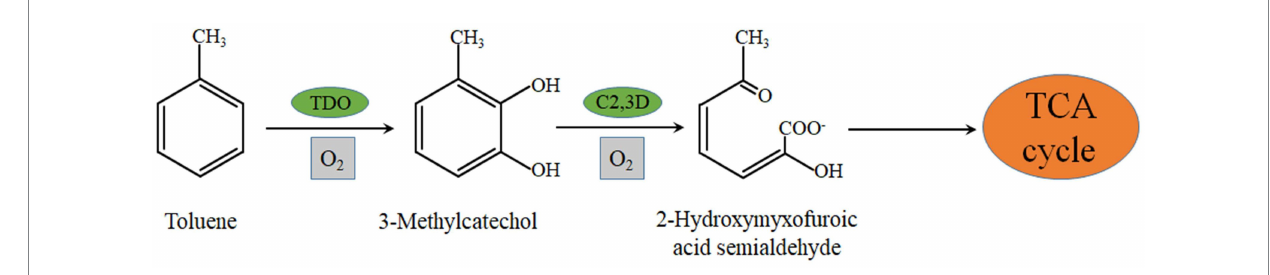
FIGURE 9 Toluene degradation pathway of EGI312 derived from analysis of key